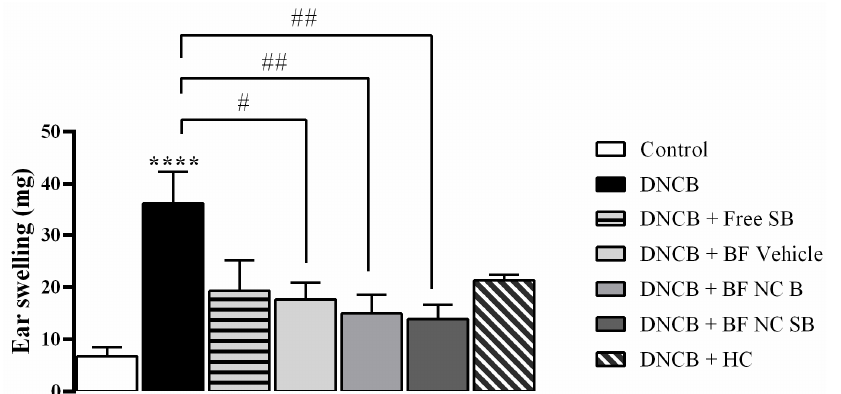
Figure 6. Effect of the different treatments on the ear swelling induced by DNCB in mice. The ear swelling was assessed on day 31 of the experimental protocol. Each column represents the mean ± SEM of 7 mice per group. (****) p < 0.0001 compared with the control group, (##) p < 0.01 and (#) p < 0.05 compared with the DNCB group (One-way ANOVA followed by the Tukey’s test).